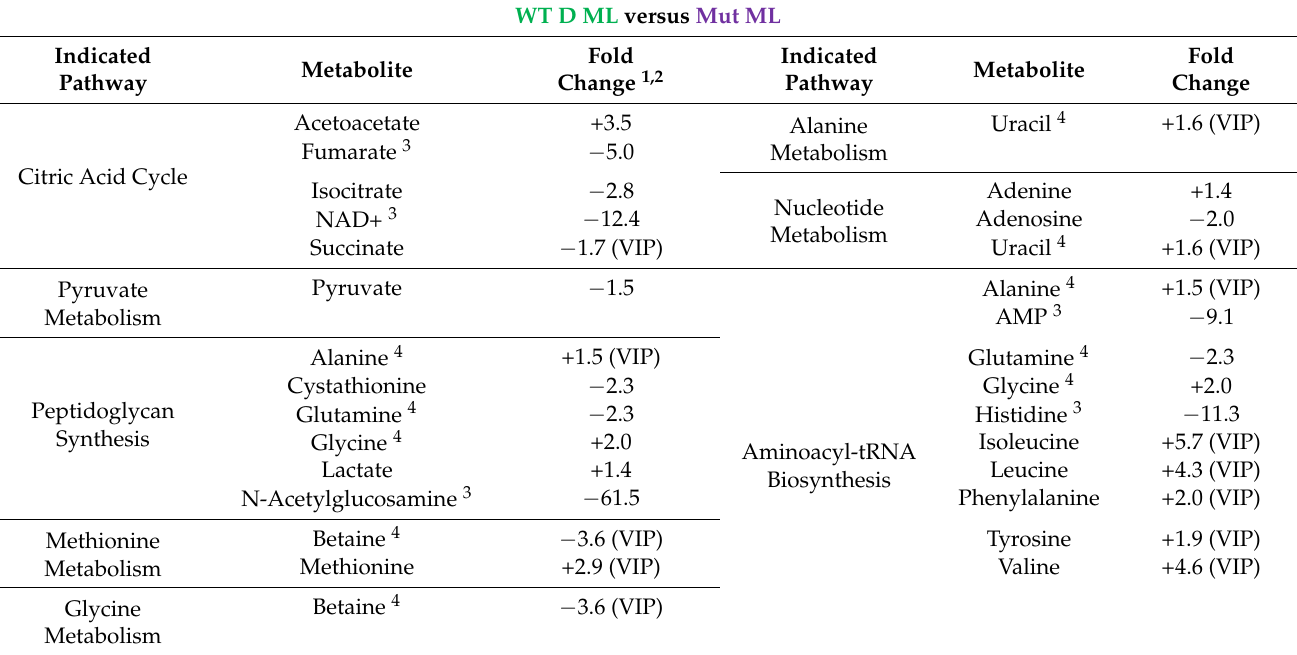
Table 10. Fold change of statistically significant metabolites in their corresponding metabolic pathways for the mid log phase of DABCOMD challenged wild type versus unchallenged